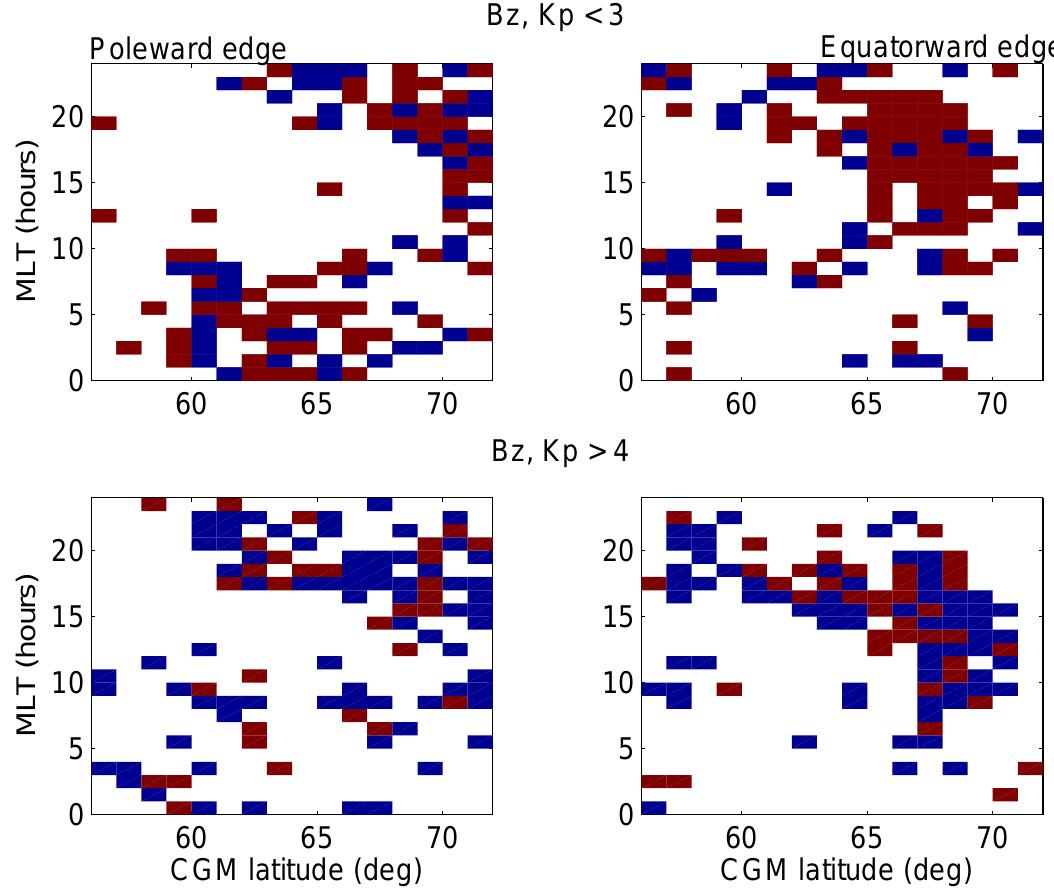
Fig. 8. The average sign (red means positive and blue negative) of Bz during observations of trough edges at different magnetic latitudes and local times. Poleward and equatorward edges are shown in the left and right panels, respectively. Top panels contain troughs observed when Kp < 3 and bottom panels when Kp > 4.